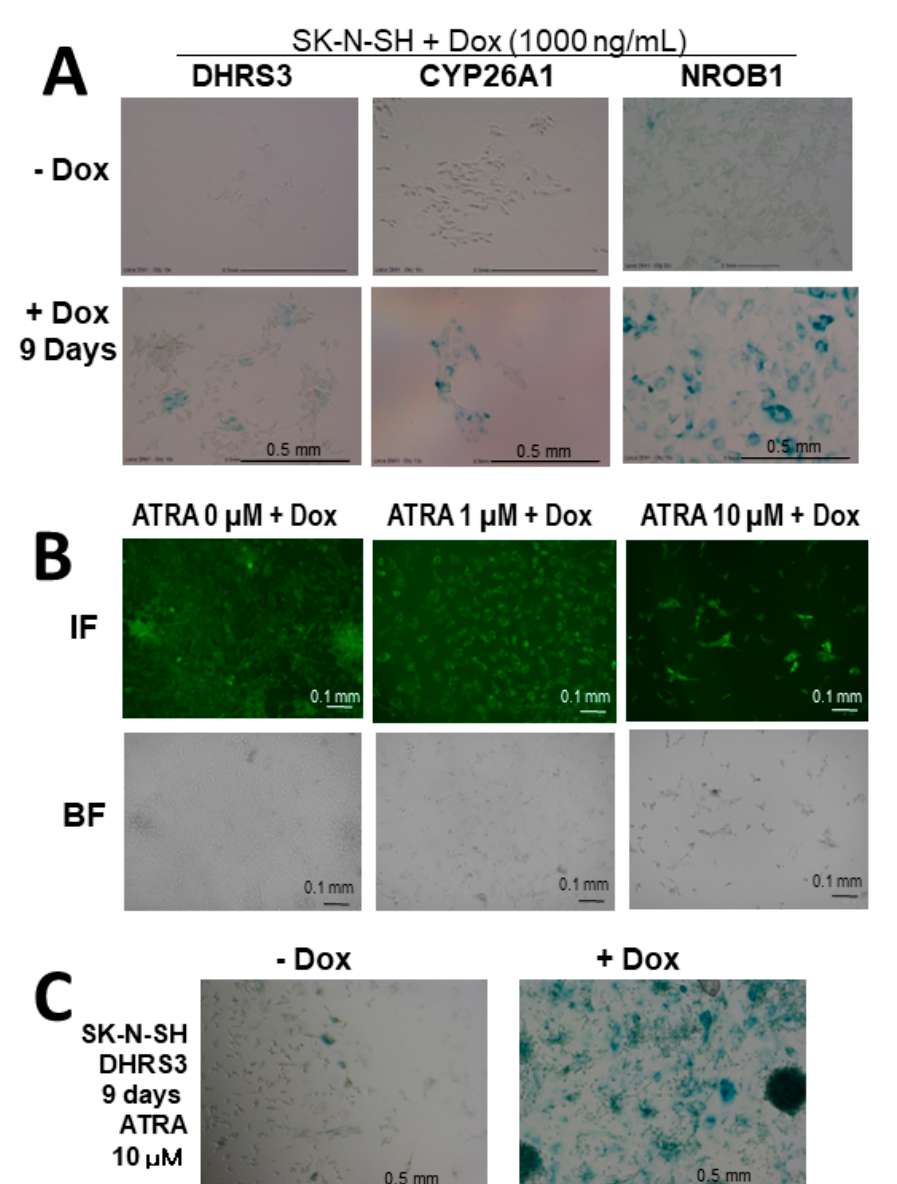
Figure 5. ATRA-inducing differentiation experiments in Dox-treated NB cells. ( A ) Expression of senescence markers in Dox-treated SK-N-SH NB cell lines. SA- β -Gal-positive cells (green). SK-N-SH cells were untreated ( − Dox) or Dox-treated until day 9 (+Dox). Ectopic Dox-induced SK-N-SH cells were observed to express high levels of a senescence marker. ( B ) Expression of Dox-treated DHRS3-expressing SK-N-SH NB cells with or without ATRA treatment. After ATRA treatment, SK-N-SH cells were assessed by immunofluorescence. High-dose ATRA induced cellular enlargement, cell death, and strong expression of DHRS3. ( C ) Expression of a senescence marker in SK-N-SH cell lines after 10 µ M of ATRA treatment. SA- β -Gal-positive cells (green). The senescence marker was higher in the Dox-treated SK-N-SH cells.